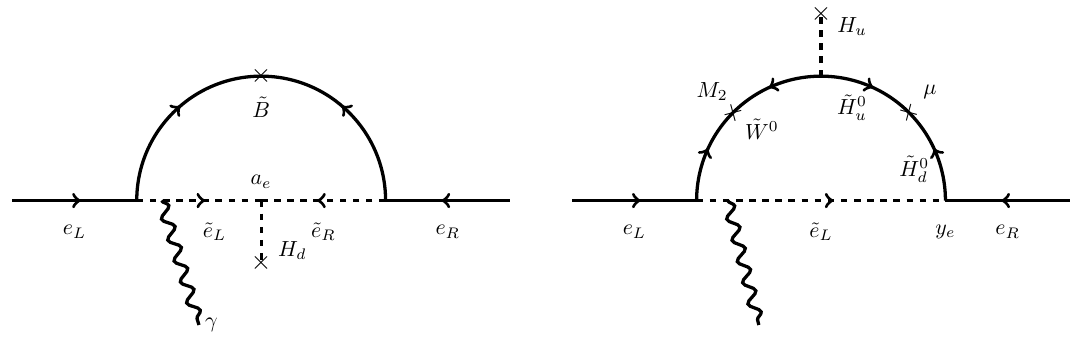
Figure 1 . One-loop EDMs in supersymmetric theories.